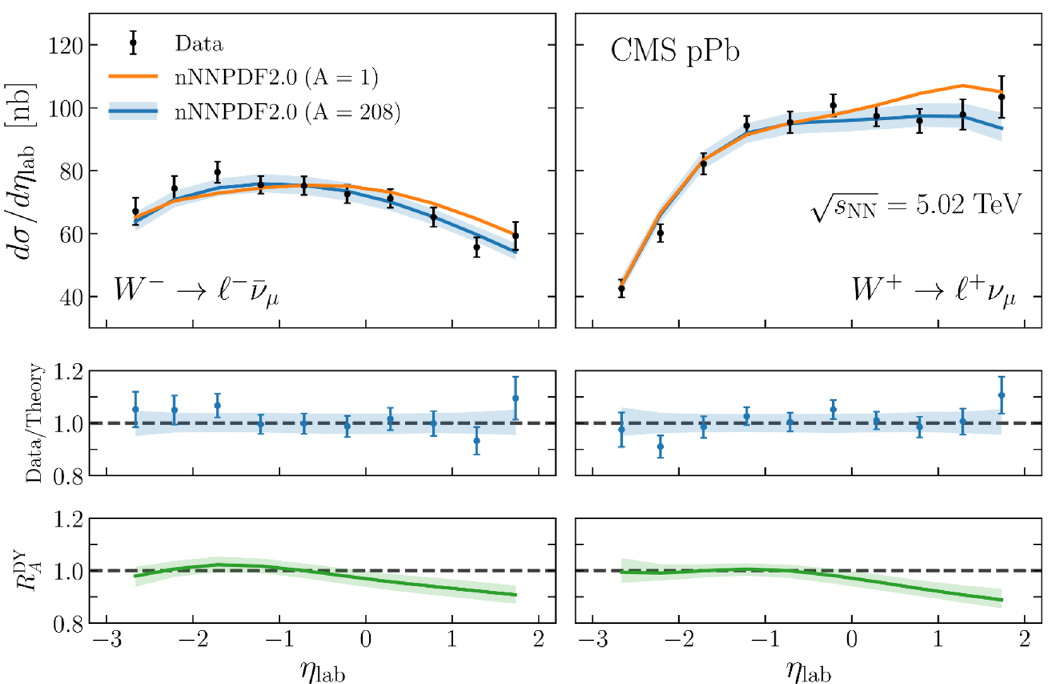
Figure 7 . Same as (cid:12)gure 6 now for the CMS muon rapidity distributions in W (cid:0) and W + production p at s = 5 : 02 TeV.